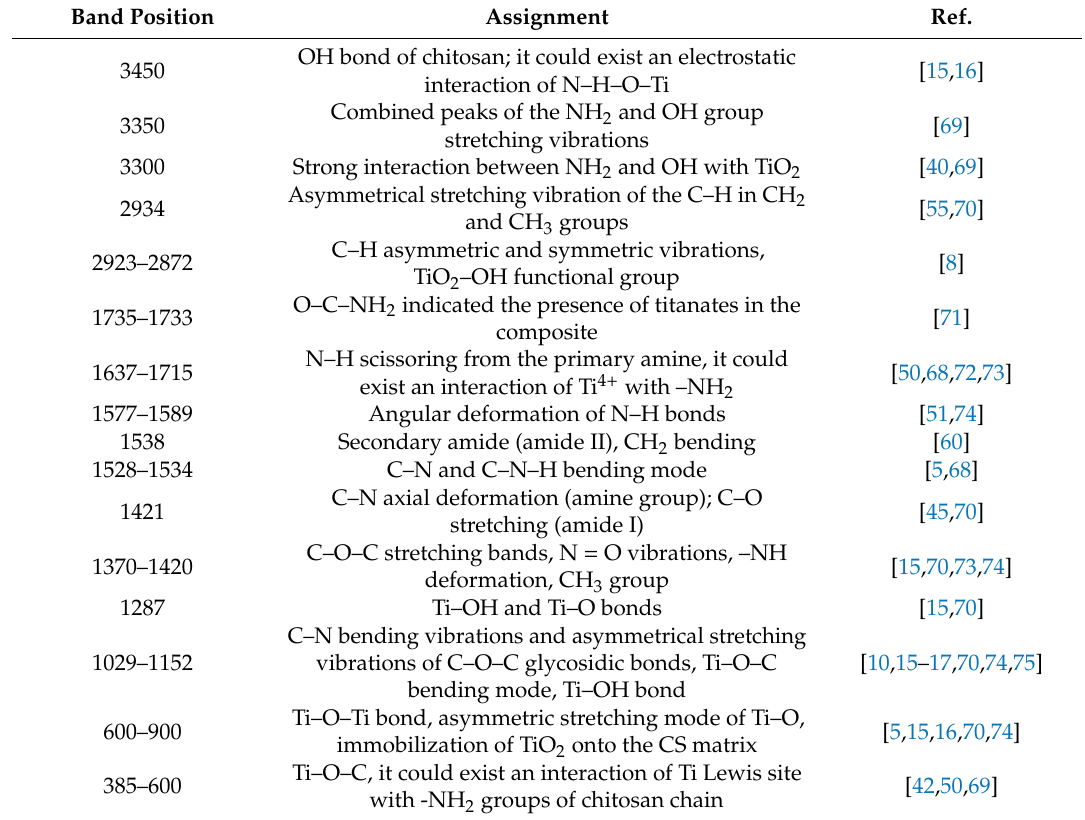
Table 3. FTIR band positions of chitosan–TiO 2